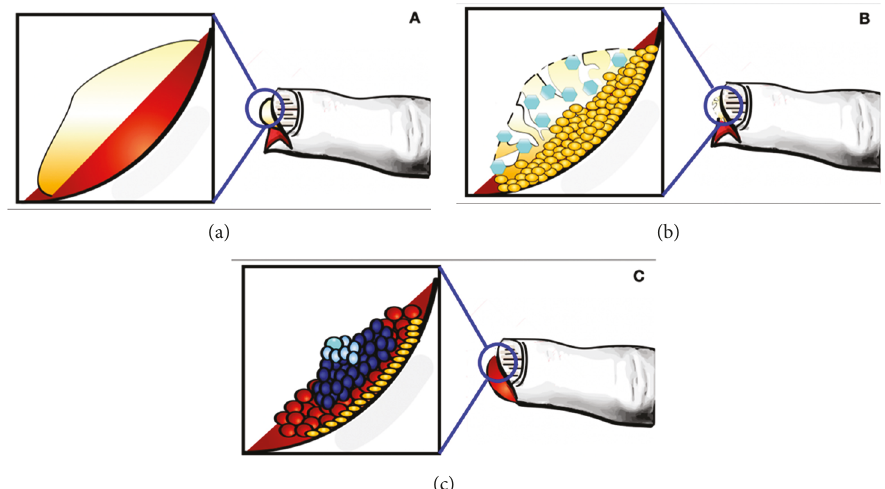
Figure 2: (a) Exposed bone and soft tissues following fi ngertip amputation through the distal phalanx. (b) Exposed bone undergoes histolysis while epidermal cells begin to cover exposed tissues. (c) Blastema of rapidly proliferating cells develops at the site of tip injury, beginning the process of digit tip